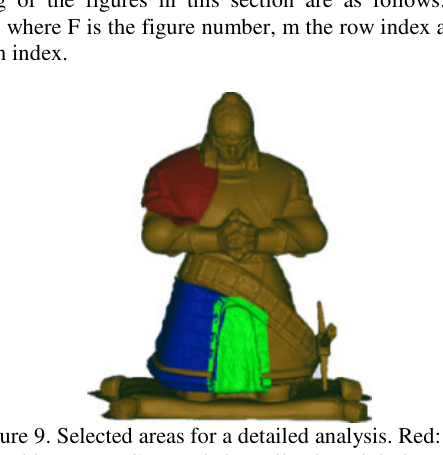
Figure 9. Selected areas for a detailed analysis. Red: right shoulder armor, Green: chain mail, Blue: right leg